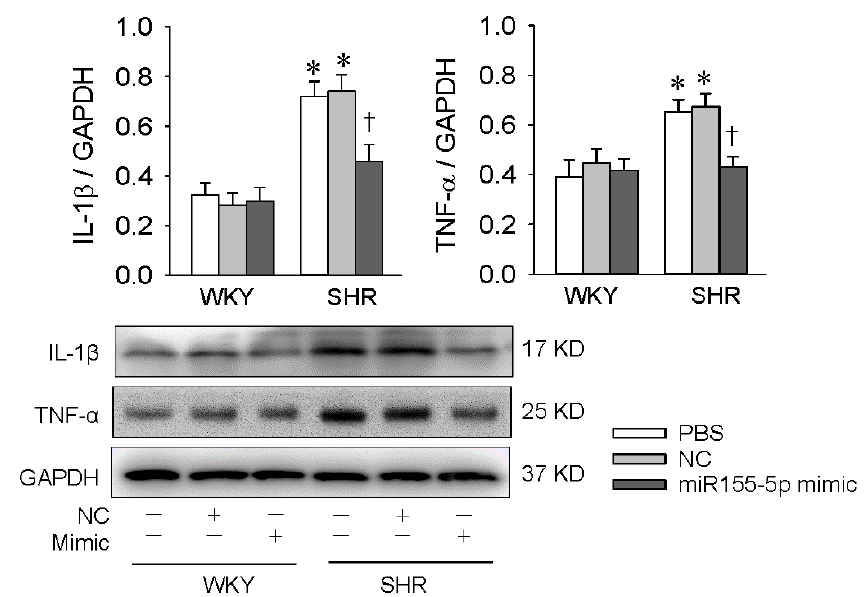
Figure 5. E ff ects of the miR155-5p mimic on IL-1 β and TNF- α expression in VSMCs. VSMCs of WKY rats and SHR were treated with PBS, negative control (NC), or the miR155-5p mimic (50 nmol / L). Measurements were made 24 h after transfection. Values are mean ± SE; * p < 0.05 vs. WKY; † p < 0.05 vs. PBS or NC; n = 4 per